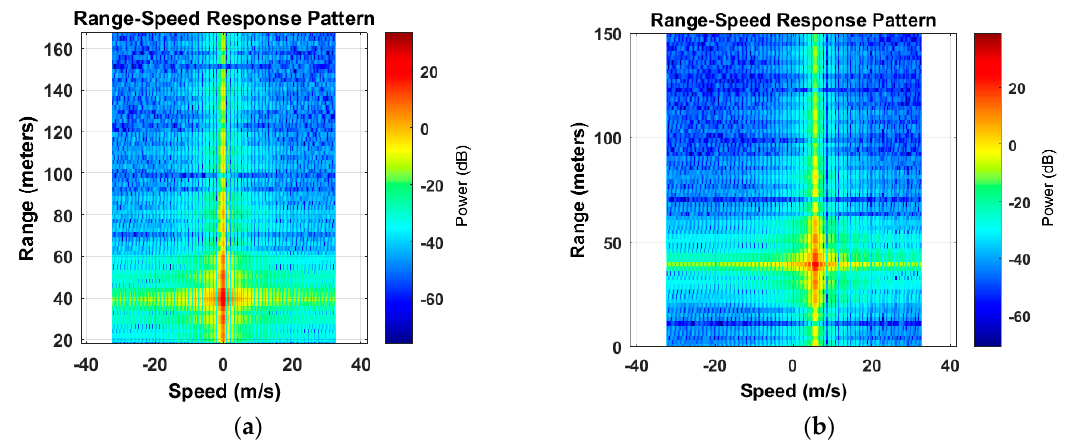
Figure 7. Computed radar pattern response ( a ) scenario 1 ( b ) scenario 2.